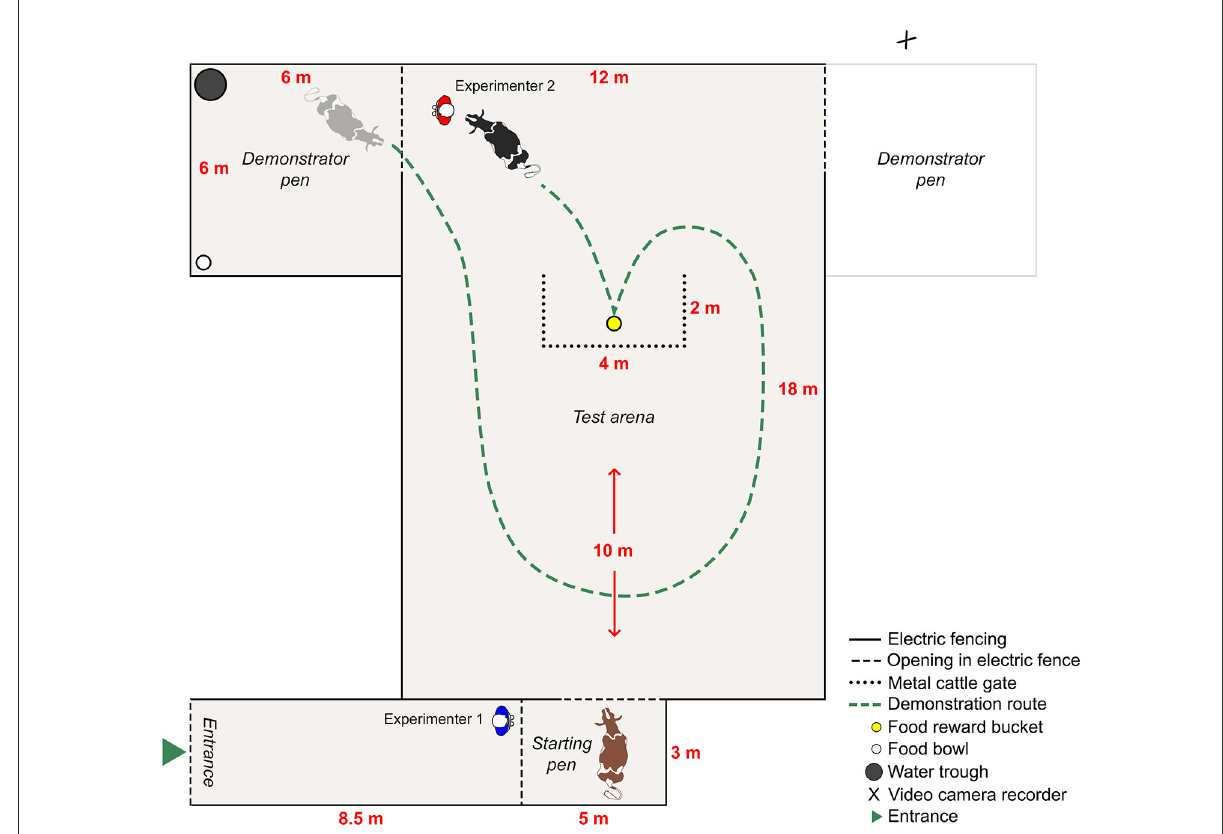
FIGURE1 The layout of the experimental venue during a right-sided demonstration of the spatial detour task, where the black cow is the demonstrator and the brown cow the observer. The grayed-out demonstrator pen was used for left-sided demonstrations, during which the video camera was moved to the opposite side of the test